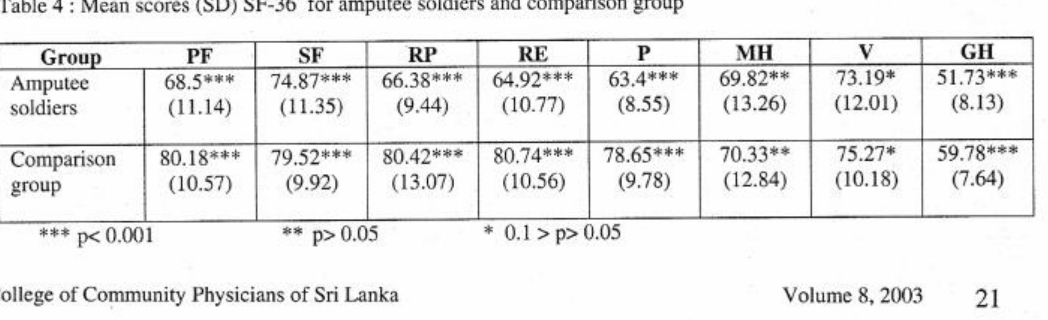
Table 4: Mean scores (SD) SF-36 for amputeesoldiers and comparison